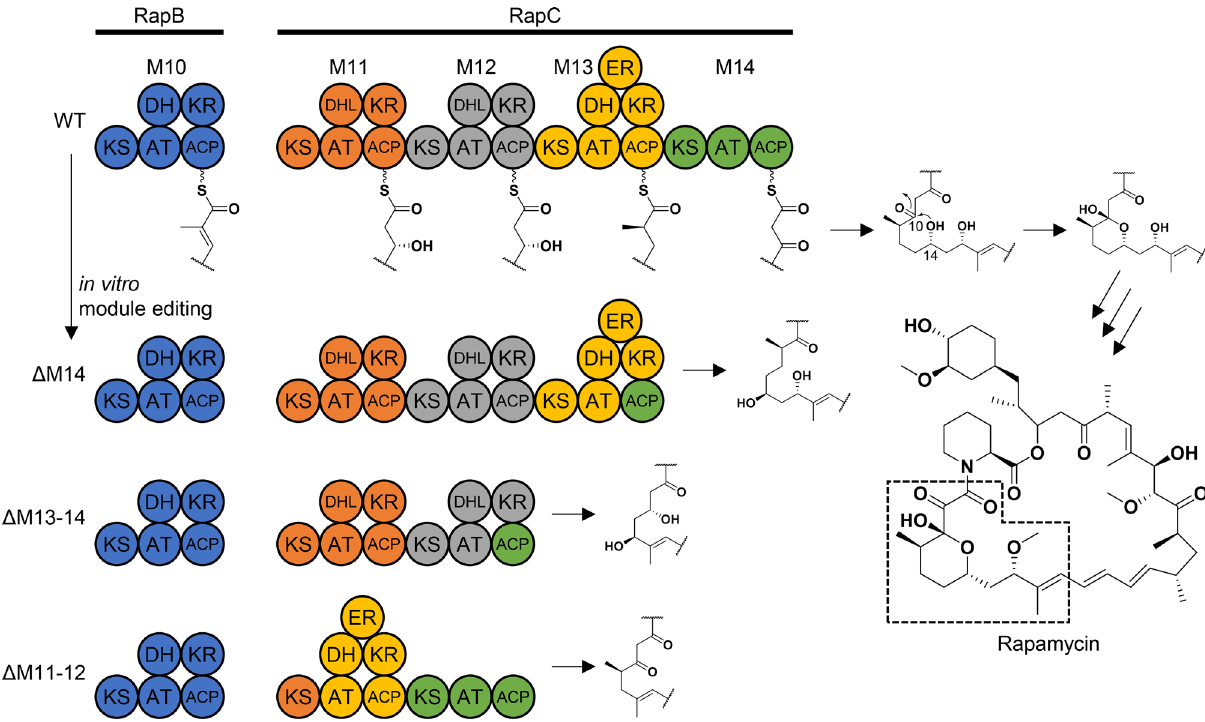
Figure 1. Domain organizations of PKSs edited to produce hemiacetal-less rapamycin derivatives. The circles represent each domain and are colored based on the traditional module boundary (start before KS and end after ACP). The polyketide substructure proposed to be biosynthesised by each engineered PKS is shown. For clarity, modules 5 to 9 of RapB are omitted. We achieved ΔM14 and ΔM13-14 by setting the editing point at the KR-ACP linker region, whereas the KS-AT linker region was used for ΔM11-12. Unlike the wild-type product of RapC, the designed intermediates are supposed to lack the hydroxyl or the ketone for forming the six-membered hemiacetal ring. KS ketosyntase, AT acyltransferase, ACP acyl carrier protein, KR ketoreductase, DH dehydratase, DHL dehydratase-like (inactive), ER enoylreductase. Dashed box corresponds to the partial structures proposed to be biosynthesized by each